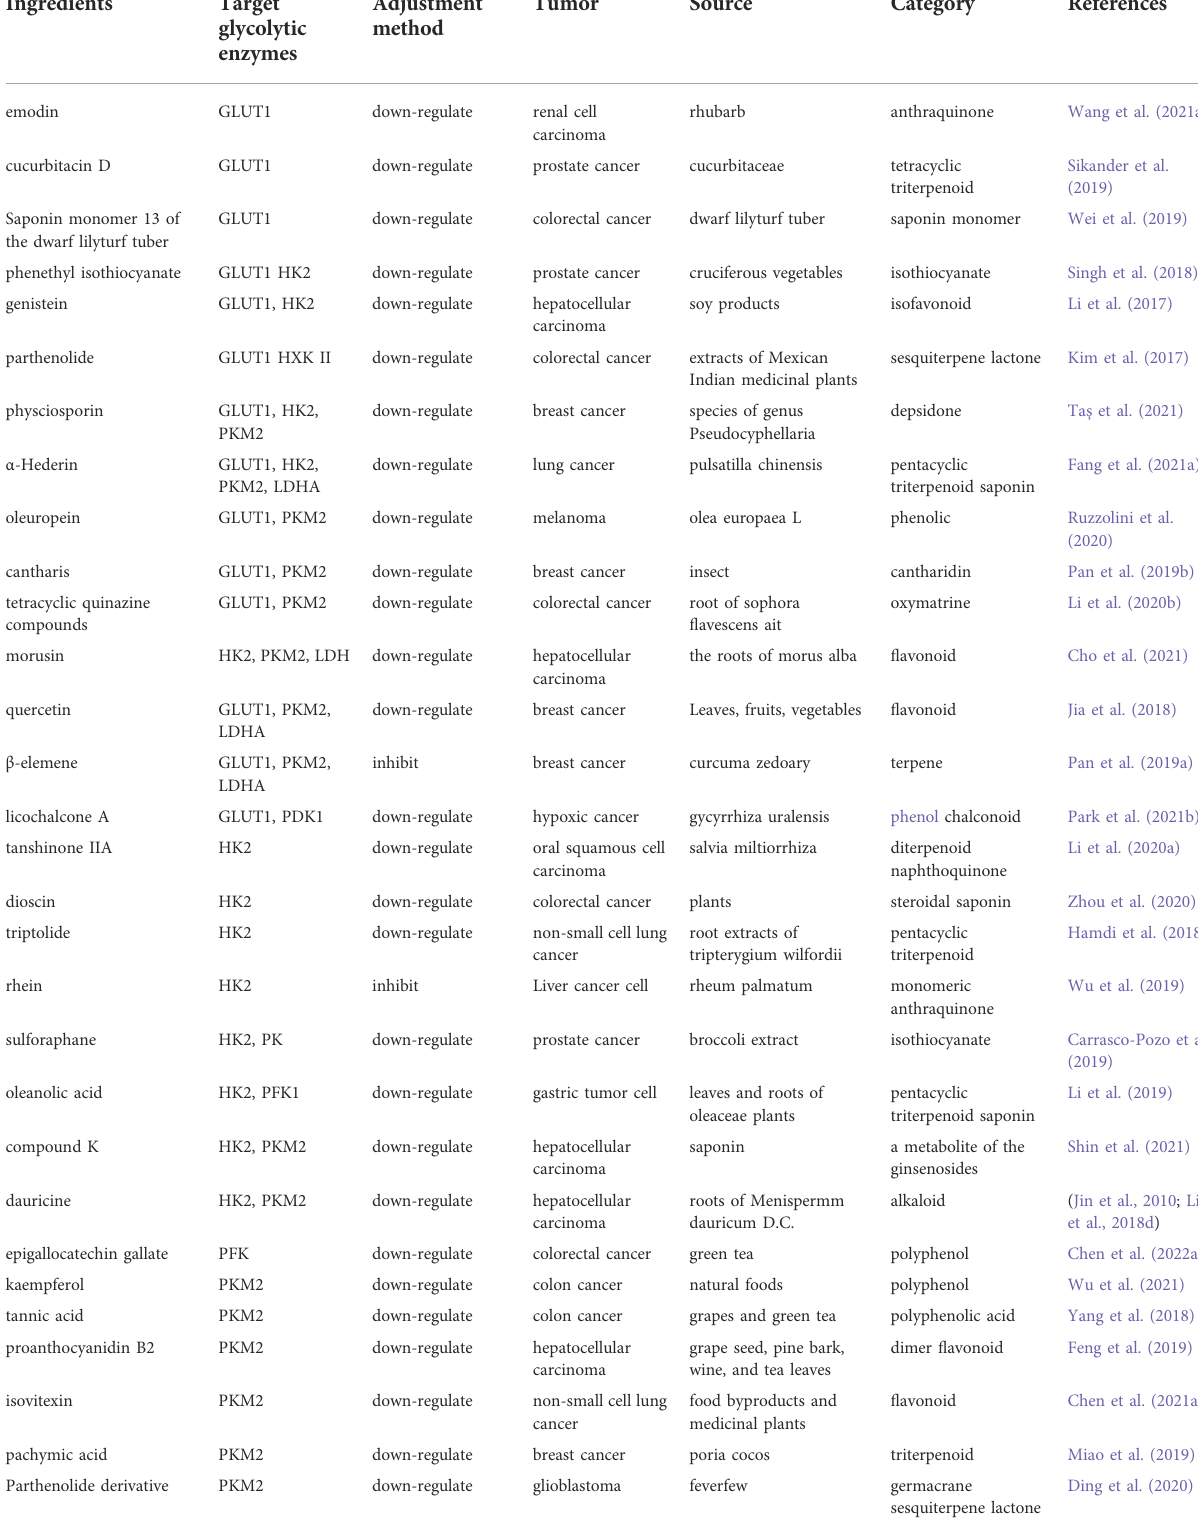
TABLE 1 Natural products regulate glycolytic enzymes in cancer.